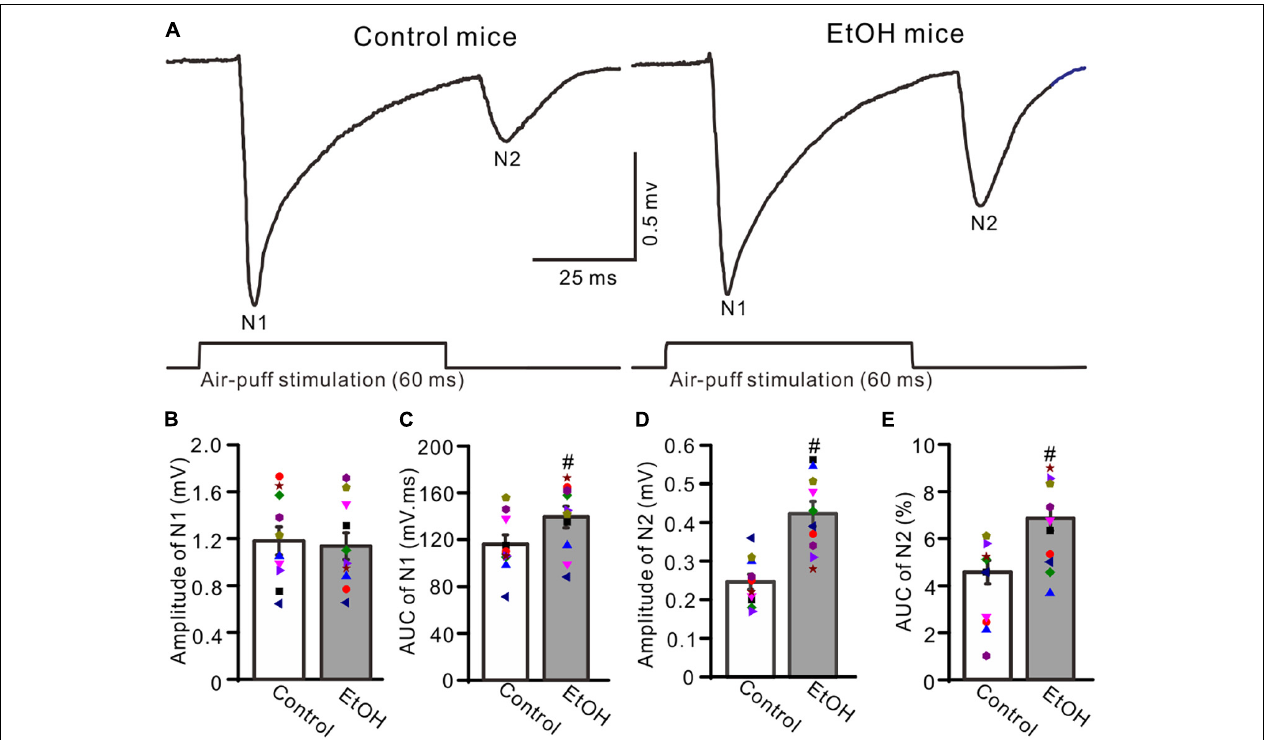
FIGURE 1 | Chronic ethanol exposure enhanced the facial stimulation-evoked mossy fiber-granule cell (MF–GC) synaptic transmission in the mouse cerebellar cortex. (A) Representative field potential recording traces showing the facial stimulation (60 ms, 50 psi)-evoked responses in the granular layer (GL) of control and ethanol-exposed mice. (B) The mean and individual data (Symbols of different colors) show the amplitude of N1 in control and ethanol-exposed (EtOH) mice. (C) A bar graph with individual data showing the area under the curve (AUC) of N1 in control and ethanol-exposed (EtOH) mice. (D,E) Bar graphs and individual data showing the amplitude (D) and AUC (E) of N2 in control and ethanol-exposed (EtOH) mice. n = 10 in each group. # P < 0.05 vs.